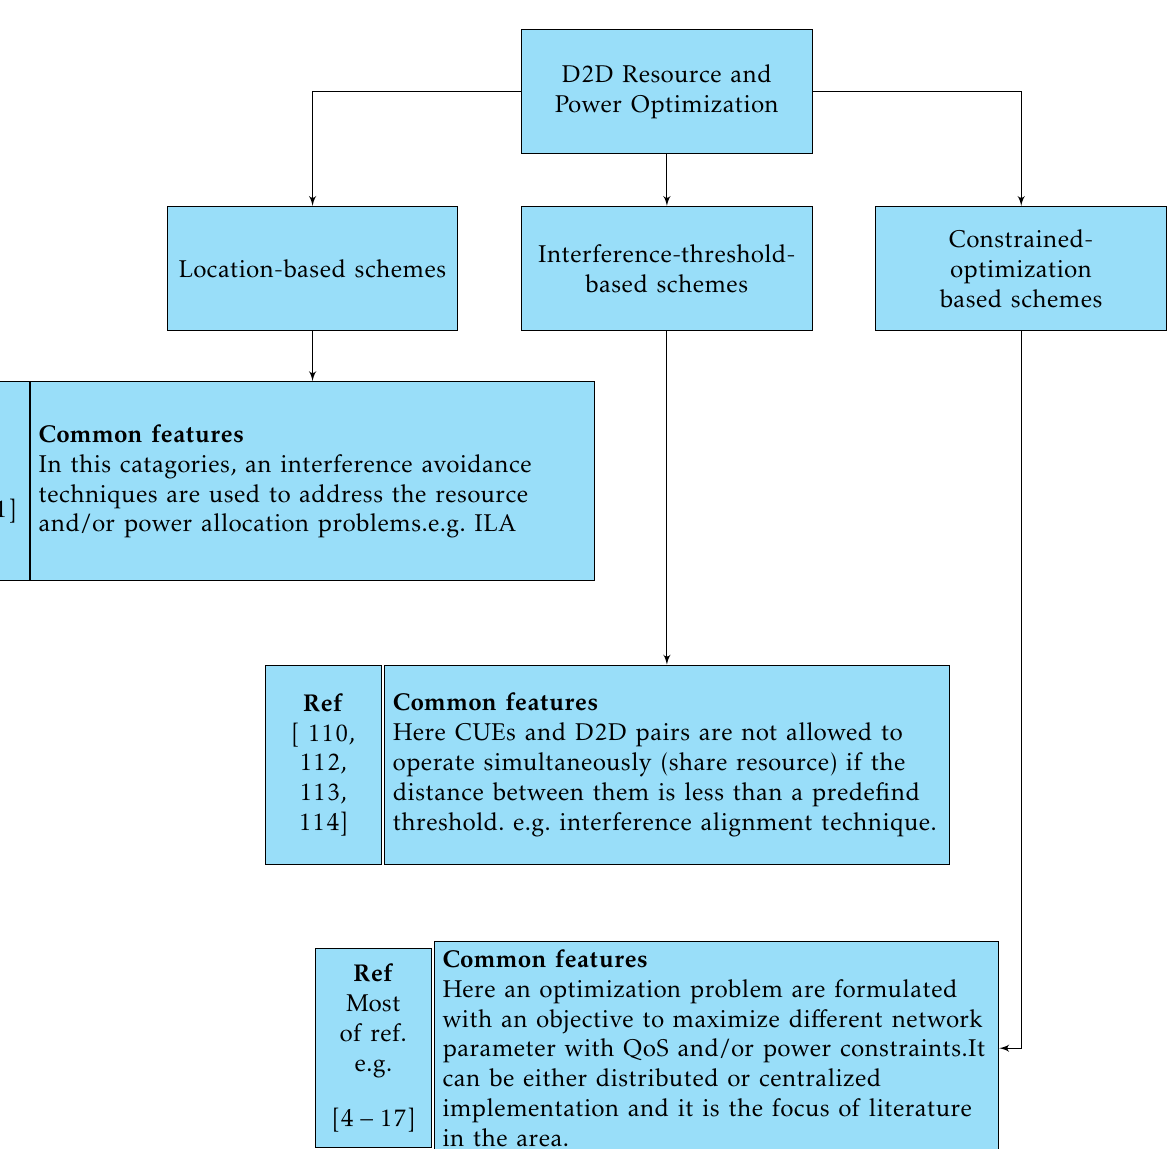
Figure 9. D2D resource assignment and power control: Solution